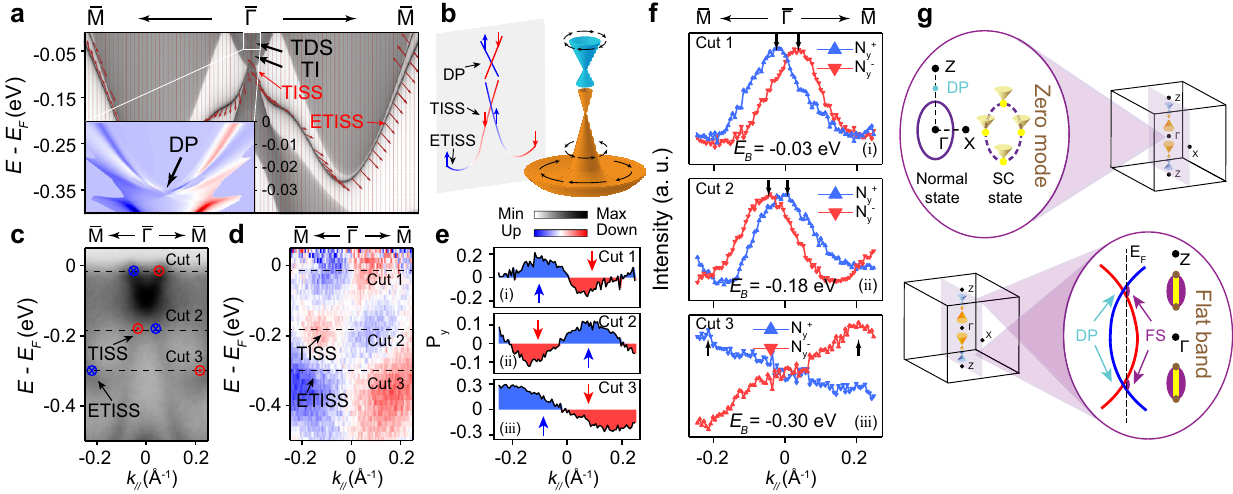
Fig. 4 Helical spin textures of surface states. a Calculated spin texture along Γ - M direction. Inset: the enlarged image of the white box region. b Sketch of the spin-polarized characteristics of TDS and TI surface states. The red and blue lines express spin down and up, respectively. c , d Intensity plot measured without and with ^ y direction spin-polarized along Γ - M direction. The red and blue parts express spin direction along - ^ y and + ^ y , respectively. e Spin polarization at Cut 1 to 3 in ( d ), indicating the spin texture of TDSS, TISS and ETISS. f Spin resolved MDCs taken at Cut 1 to 3. g Sketch of the dual topological superconductivity states induced by TDS